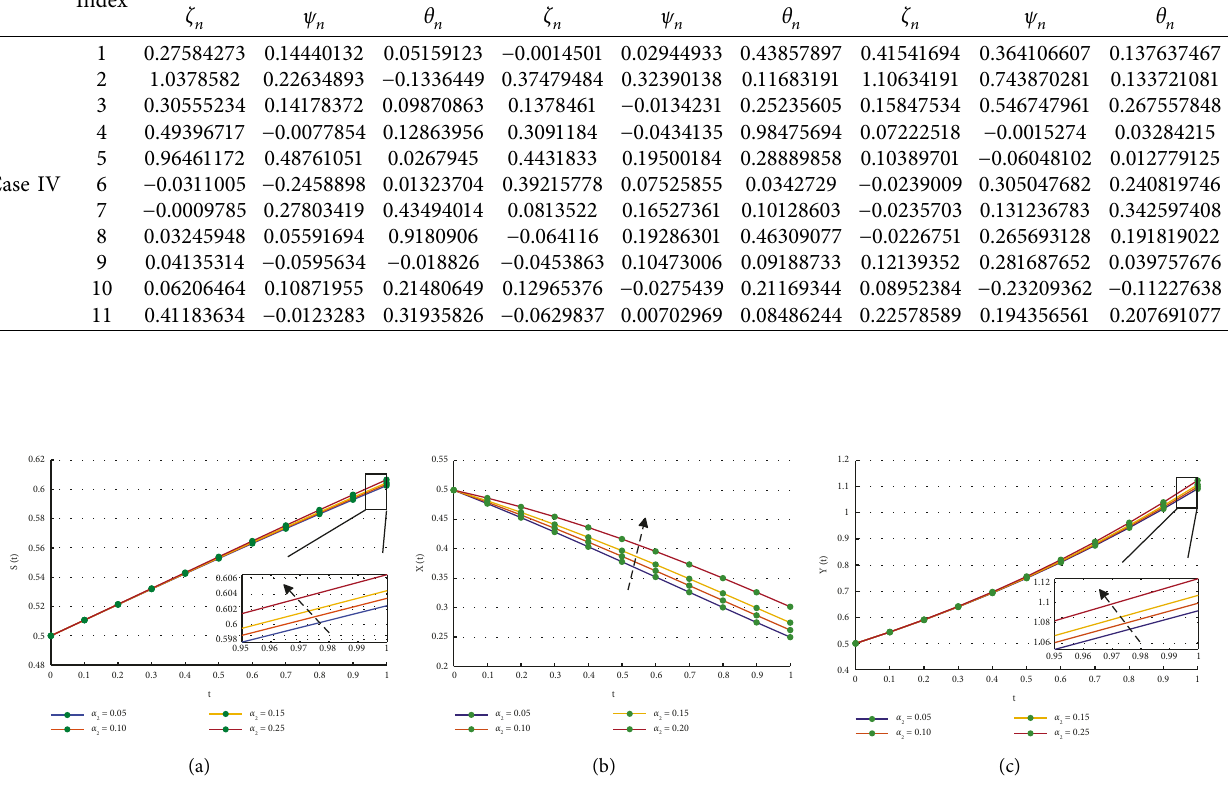
Figure 12: Comparison between solutions obtained by the LeNN-WOA-NM algorithm under the influence of variations in the increasing rate of immigrant prey on population densities of the prey-predator model. (a) Approximate solutions for population density of local prey. (b) Approximate solutions for population density of immigrant prey. (c) Approximate solutions for population density of the predator. Table 27: Comparison between solutions obtained by the LeNN-WOA-NM algorithm and ode45 for the prey-predator model under the influence of variations in β . 2